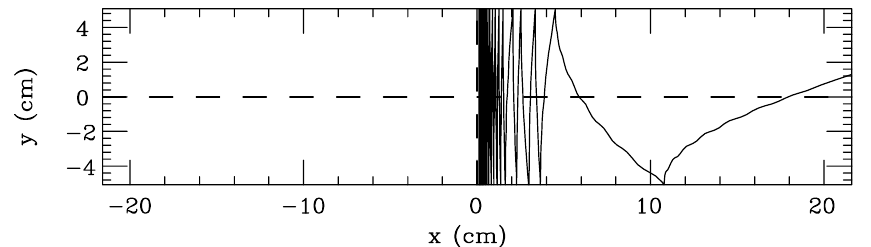
FIG. 4. Trajectory of an electron launched 1 mm from the midline in CESR rectangular waveguide propagating the TE 10 mode.